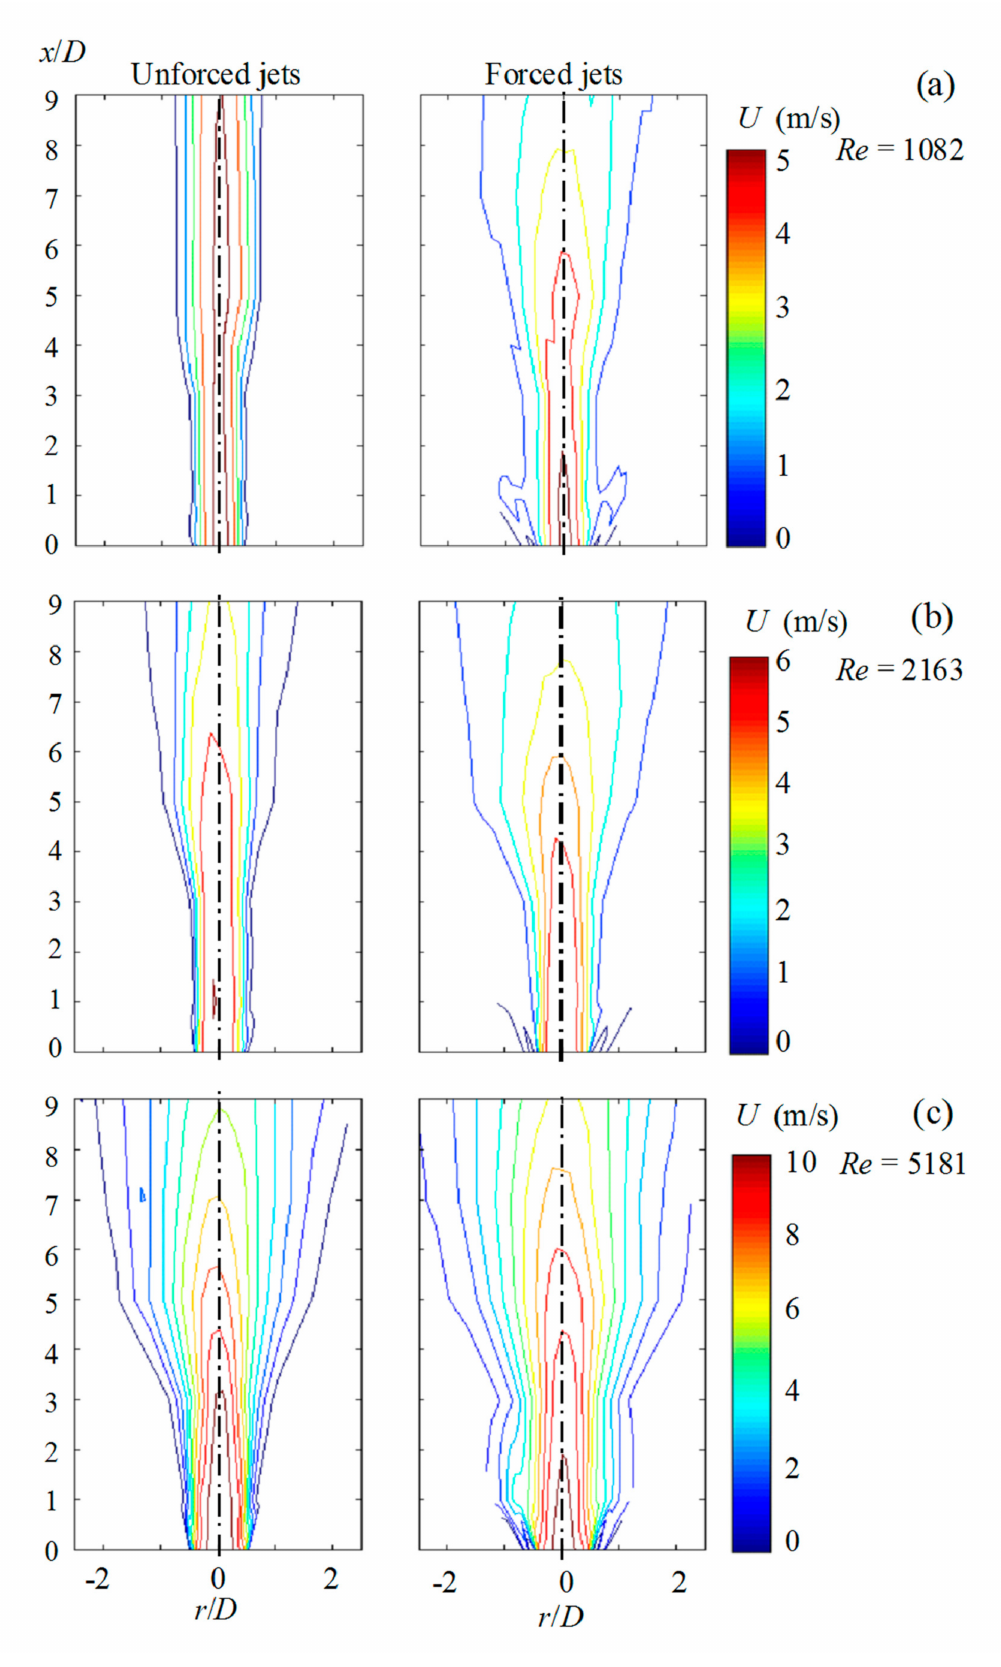
Figure 9. Time-mean velocity maps: ( a ) Re = 1082; ( b ) Re = 2163; ( c ) Re =